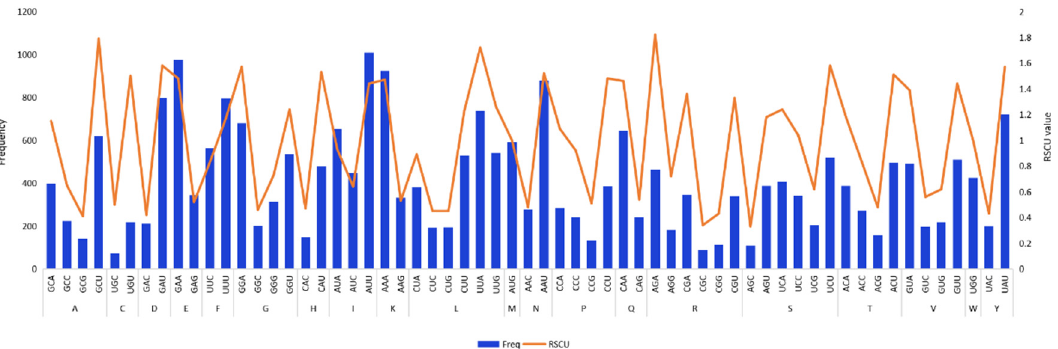
Figure 2. The frequency (Freq) and preference of codon usage (RSCU) in L. moupinensis protein-coding region. Axis of abscissae indicate each amino acid and its abbreviation as well as the respective codon, the blue bar in the figure is the frequency of codon usage, and the orange line represents codon